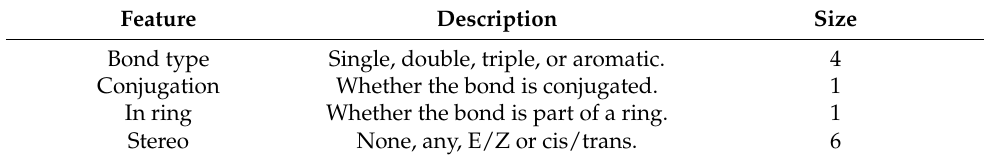
Table A3. Bond features used in our method. These features are one-hot encoding.